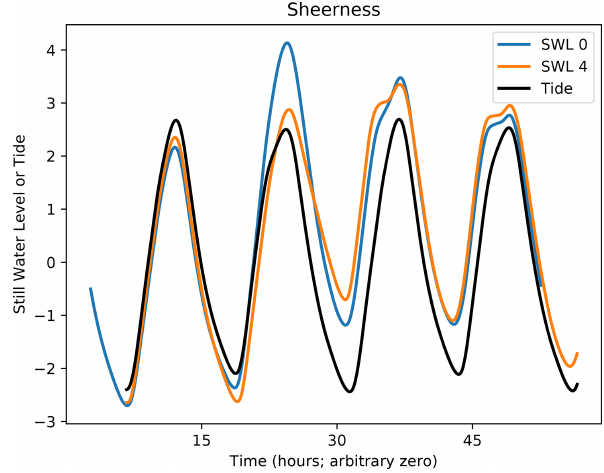
Figure 4. A simulated extreme event on a spring tide showing the effect of a shift of 4h in the timing of the event relative to the